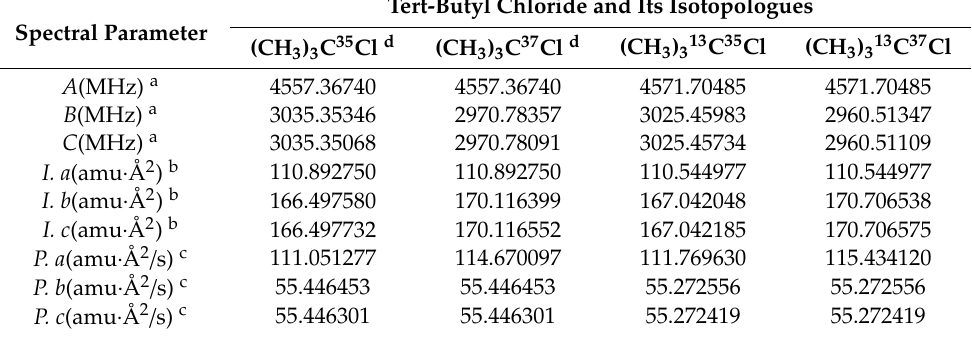
Table 1. The rotational constant, moment of inertia and rotational angular momentum of (CH 3 ) 3 C 35 Cl,